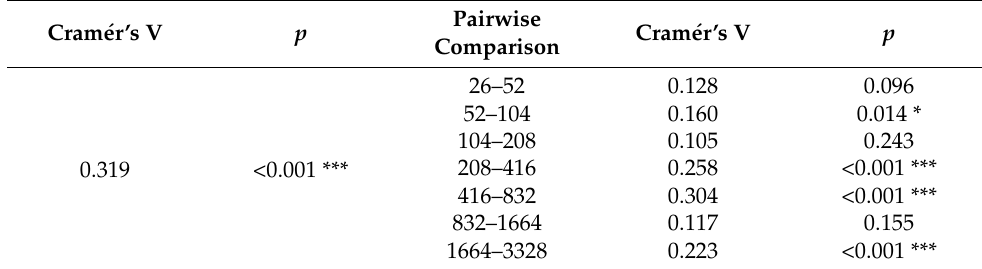
Table 2. The pairwise comparison of the collected answers for task 3. * p < 0.05, *** p ≤ 0.001.